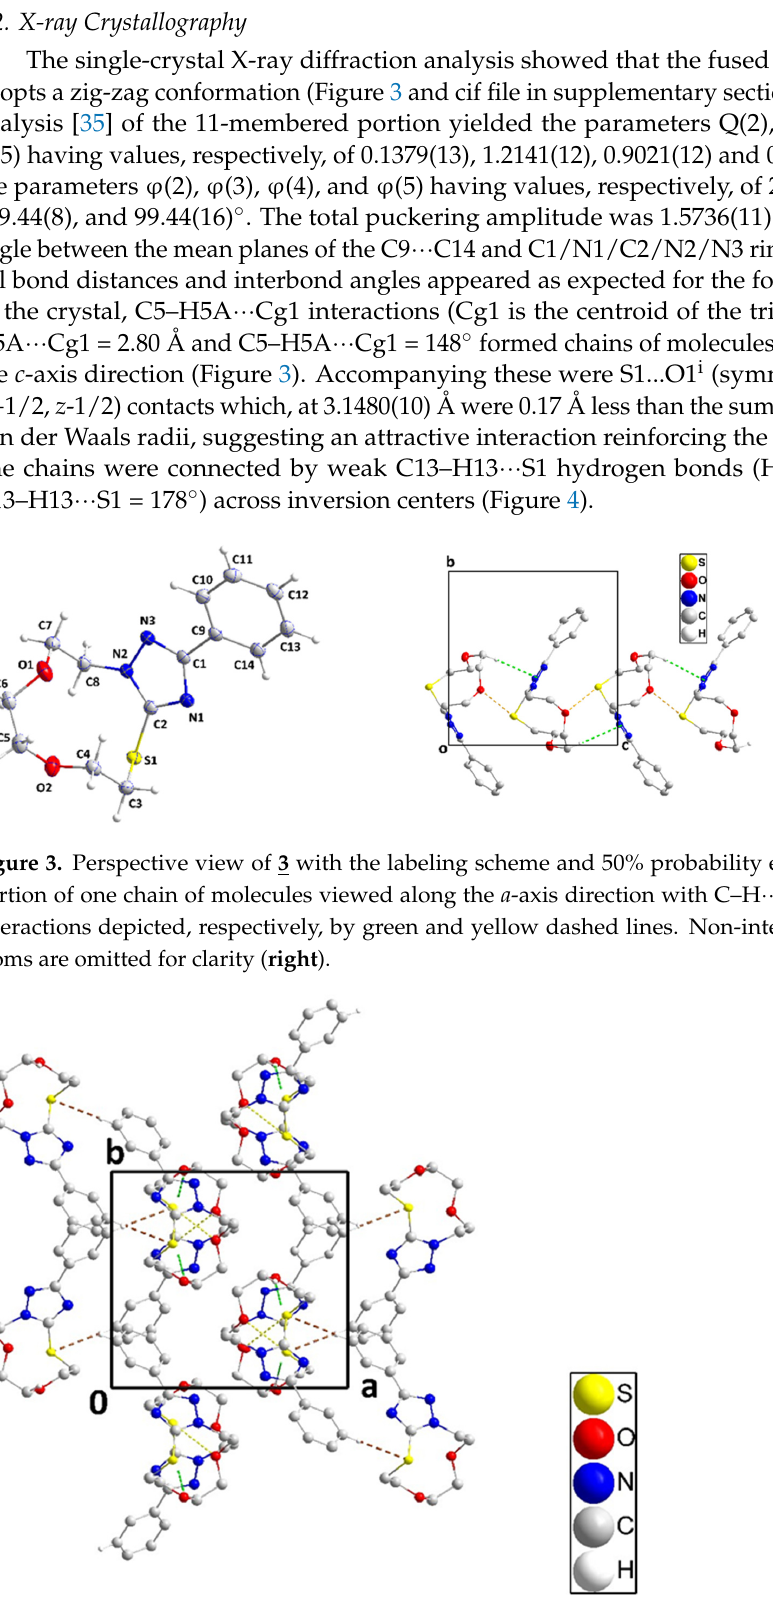
Figure 4. Packing of 3 viewed along the c-axis direction with C–H ⋅⋅⋅ S hydrogen bonds and C– H ⋅⋅⋅ π (ring) and O ⋅⋅⋅ S interactions depicted, respectively, by brown, green, and yellow dashed lines. Non-interacting hydrogen atoms are omitted for clarity.